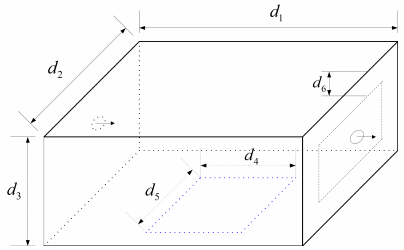
Figure 4. The configuration of the thermostat. Table 1. Parameters of the thermostat.